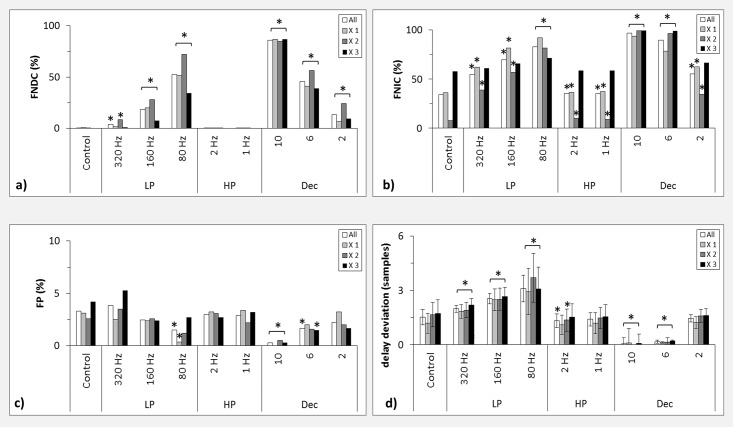
Results for the CLMM.False detections in percent for different branches of CLMM reflecting different degrees of nonlinearity for a) FNDC, b) FNIC, and c) FP. d) Delay deviation in samples for different degrees of nonlinearity. LP: low-pass filter, HP: high-pass filter, Dec: decimation, X i: ith branch of the CLMM, All: average results for all degrees of nonlinearity. Asterisks indicate results significantly different from control (a-c: Fisher’s exact test, p < = 0.05, Bonferroni corrected, d: Wilcoxon rank-sum test, p < = 0.05). Error bars indicate standard deviation.